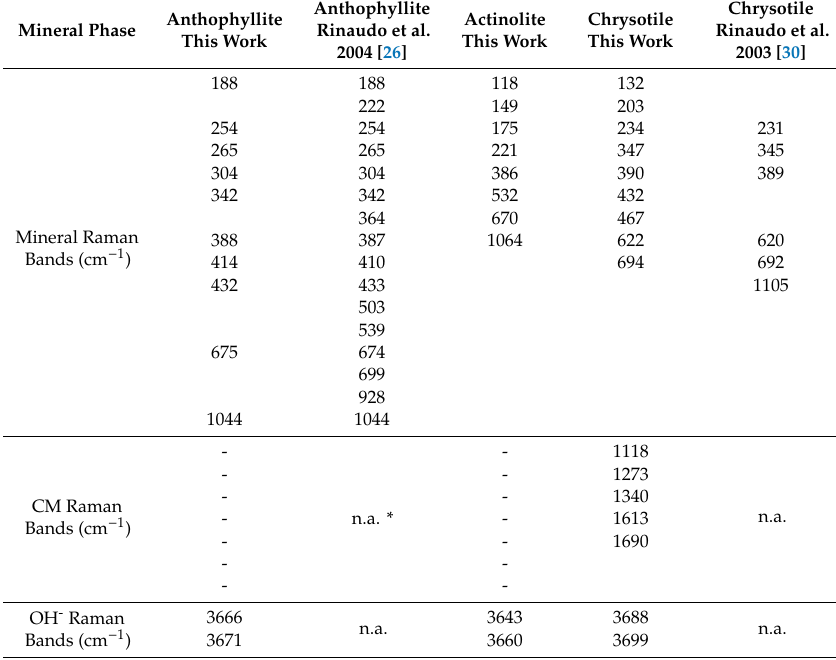
Table 2. Raman bands observed on the mineral phases defined “asbestos” by the